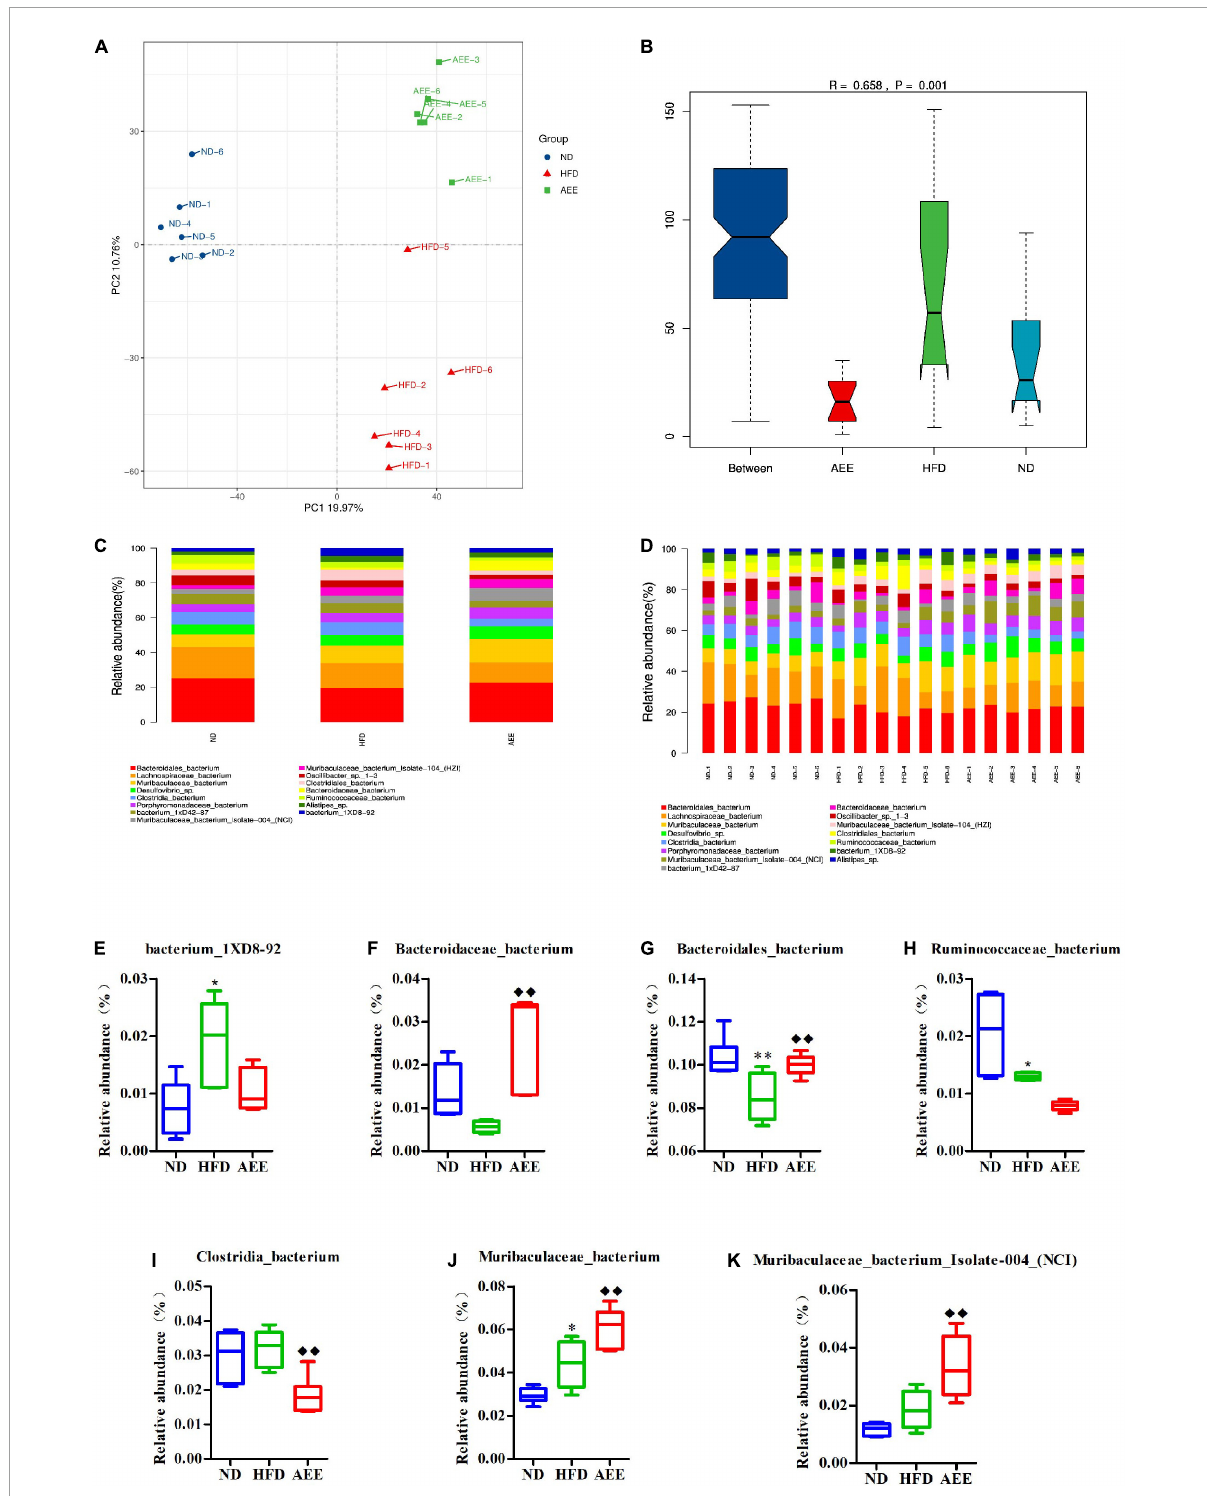
FIGURE8 Microbiota compositions at the Species level. (A) PCA results of the similarities in bacterial community structures at the Species level. (B) Analysis of Anosim based on Species level. (C,D) Histogram of relative abundance at the Species level. (E–K) Relative content of bacterium_1XD8-92, Bacteroidaceae_bacterium, Bacteroidales_bacterium, Clostridia_bacterium, Muribaculaceae_bacterium, Muribaculaceae_bacterium_Isolate-004_(NCI), and Ruminococcaceae_bacterium at the Species level. Values are presented as mean ± SD ( n = 6). Differences were assessed by ANOVA and denoted as follows: ∗∗ P < 0.01, ∗ P < 0.05 compared with the ND group; (cid:117)(cid:117) P < 0.01 compared with the HFD